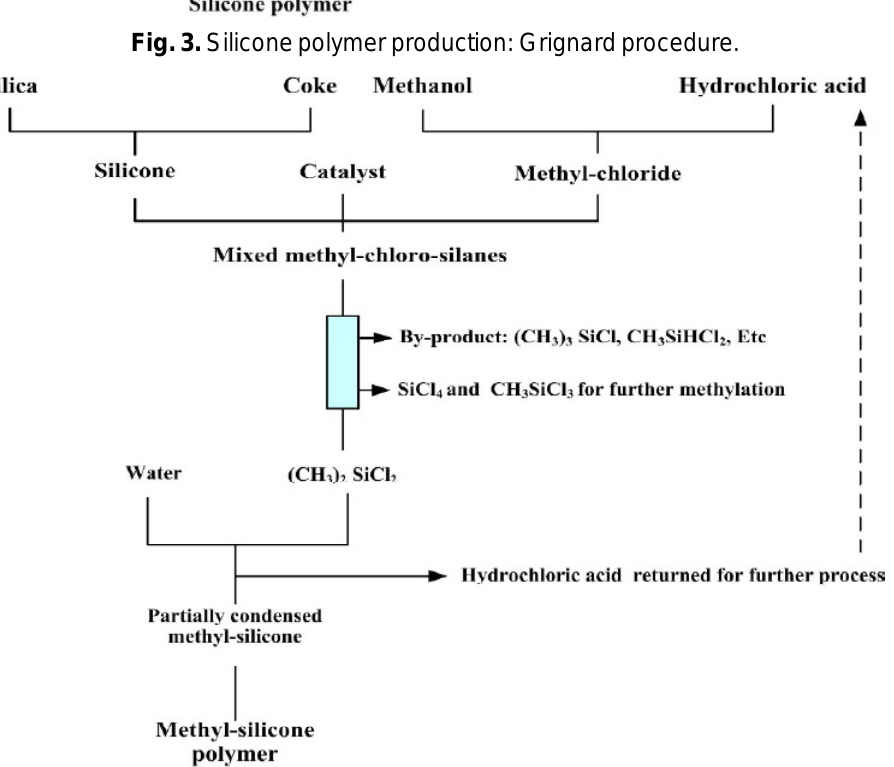
Fig. 3. Silicone polymer production: Grignard procedure.